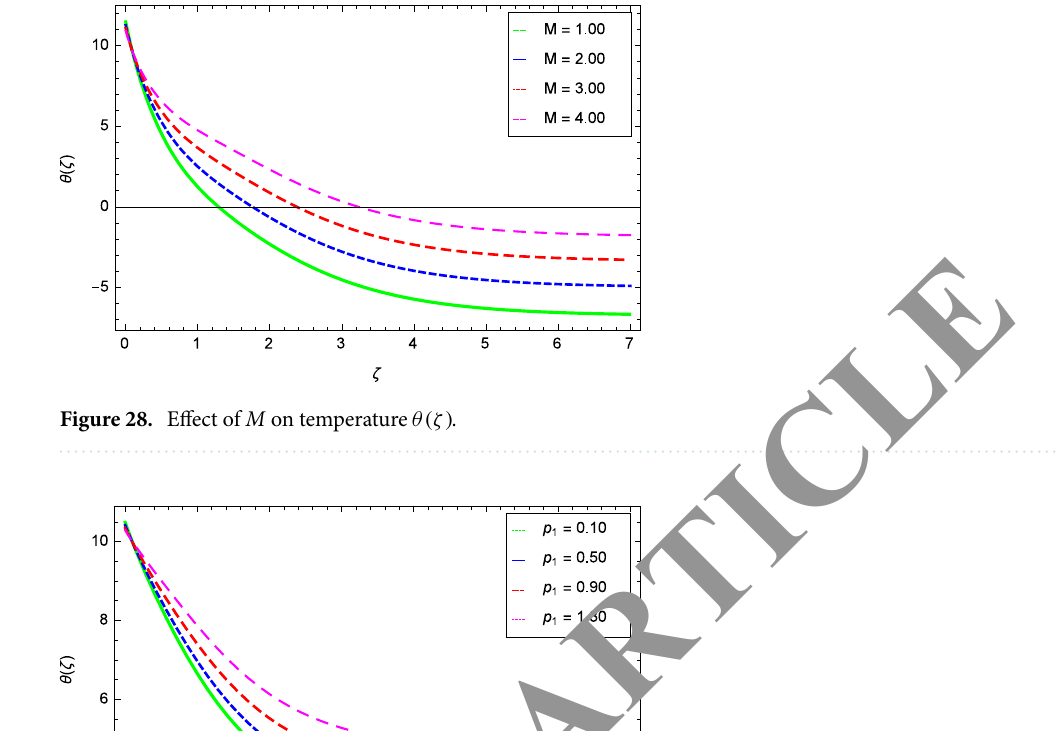
Figure 29. Effect of p 1 on temperature θ(ζ) .